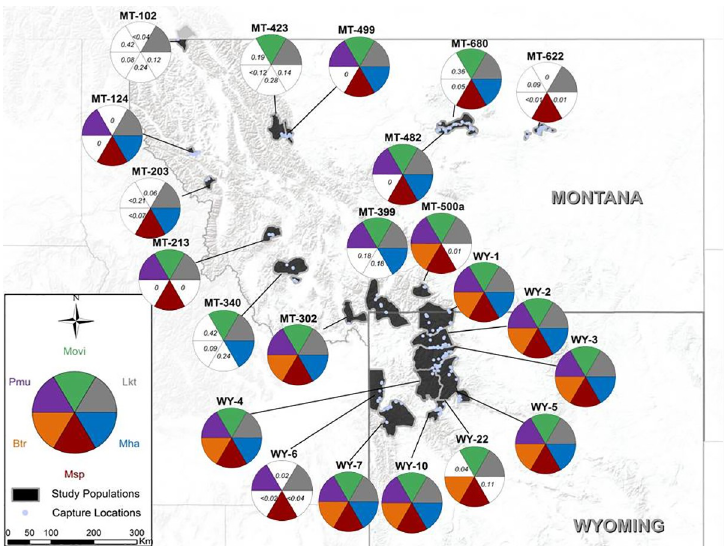
Fig 1. Map of bighorn sheep study populations and detected respiratory pathogen communities. All sections of the pie-charts are fixed to equal size and represent whether the respective pathogens were detected in the study population. The key for pathogen abbreviations are as follows: Movi = Mycoplasma ovipneumoniae, Mha = leukotoxigenic Mannheimia haemolytica/glucosida, Msp = leukotoxigenic Mannheimia spp., Btr = leukotoxigenic Bibersteinia trehalosi, Pmu = Pasteurella multocida, Lkt = Leukotoxin. Where pathogens were not detected, the numbers in the unfilled section indicate the probability the pathogens were present.